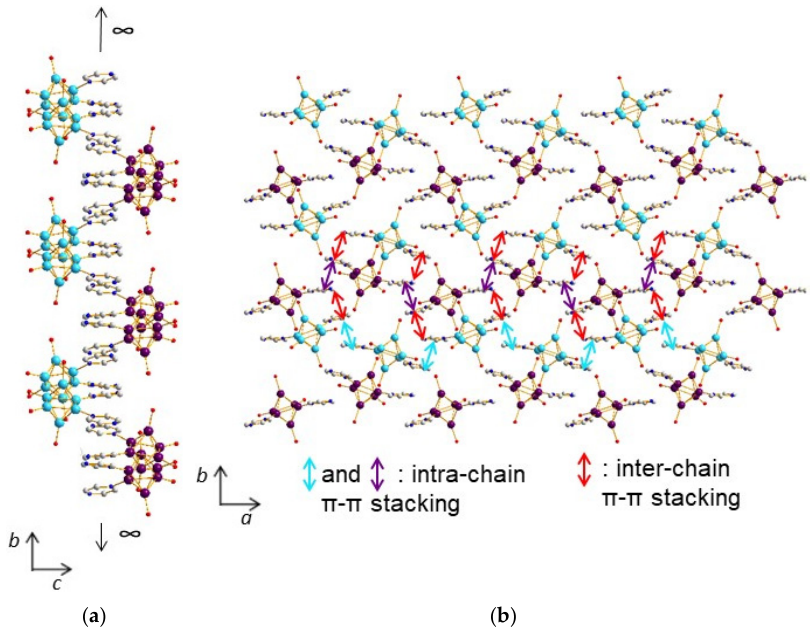
Figure 8. ( a ) Stacking of the chains along the b axis through π – π interactions involving adjacent coordinated pyrazine molecules in the structure of ( 4 ). ( b ) Infinite two-dimensional layers resulting from intra- and inter-chain π – π stacking of the aromatic cycles in the structure of ( 4 ).